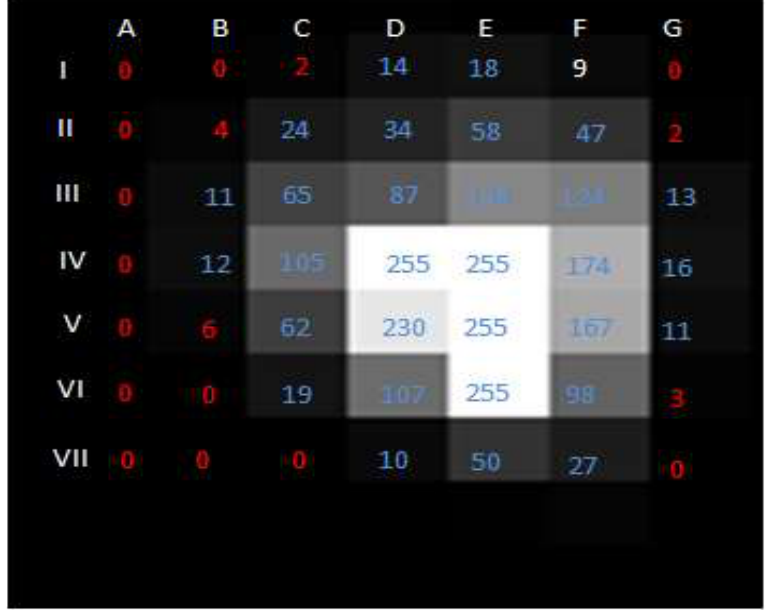
Figure 2. Grayscale variations of a protrusive defect with respect to the threshold.